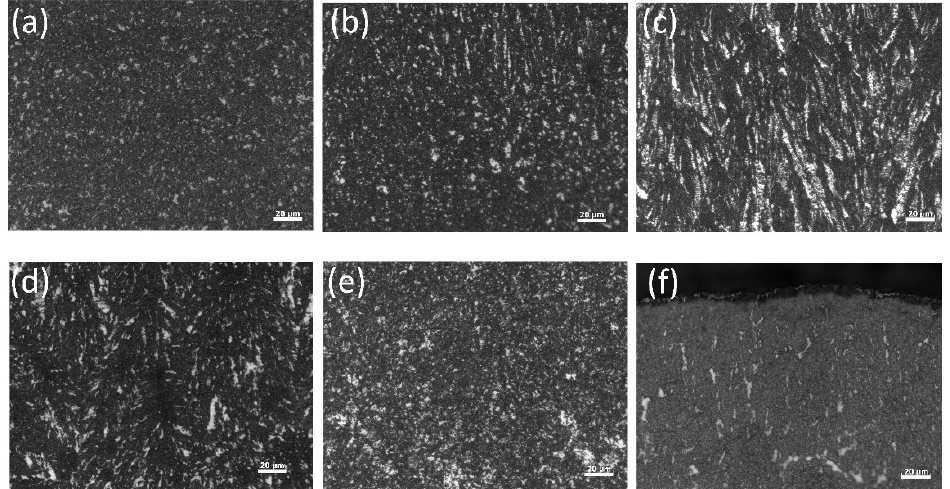
Figure 3. Metallographic organization diagram of copper deposits: ( a ) − 5 ◦ C, ( b ) − 3 ◦ C, ( c ) − 1 ◦ C, ( d ) 1 ◦ C, ( e ) 3 ◦ C, ( f ) 5 ◦ C. The distributions of the metallographic structure in ( c , d ) are uneven, and the size is obviously larger than that at other temperatures.